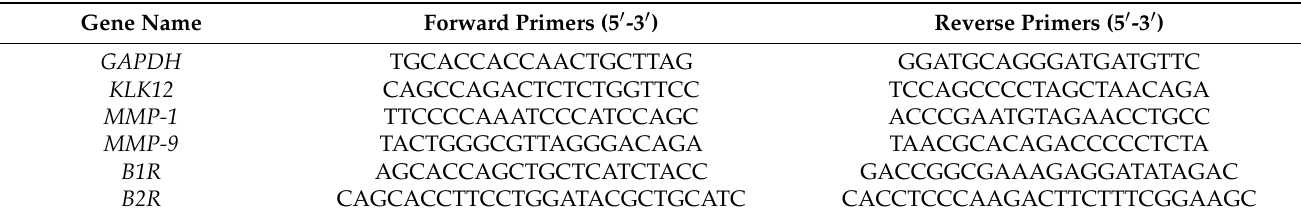
Table 2. Primers used in the present